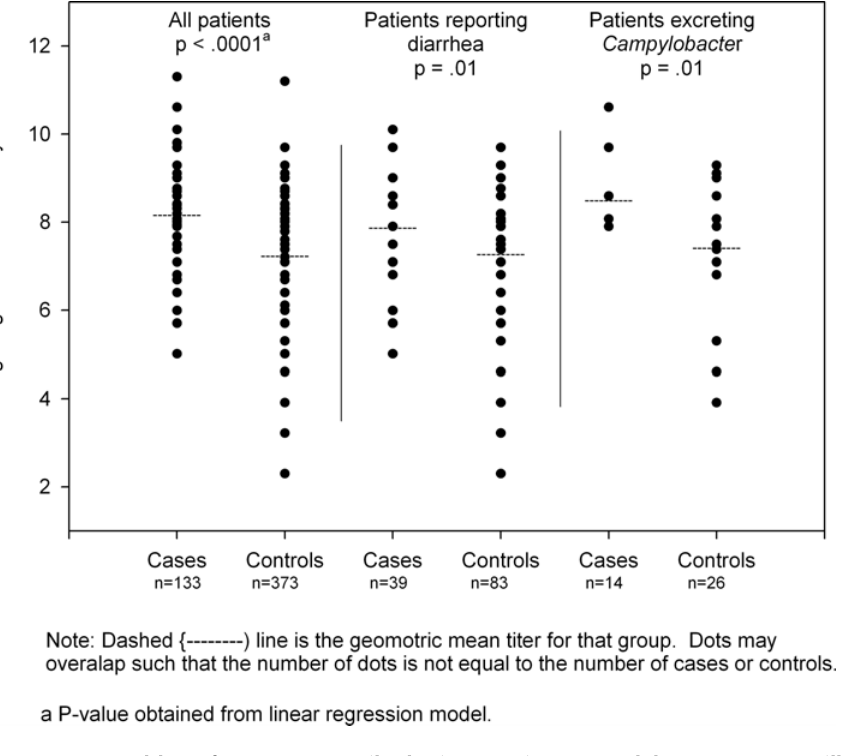
Figure 1. Natural log of IgM serum antibody titers against Campylobacter among Guillain-Barre´ Syndrome cases and patient- controls and among cases and controls reporting diarrhea or excreting Campylobacter, the Arab Republic of Egypt, April 2001 through September 2003.